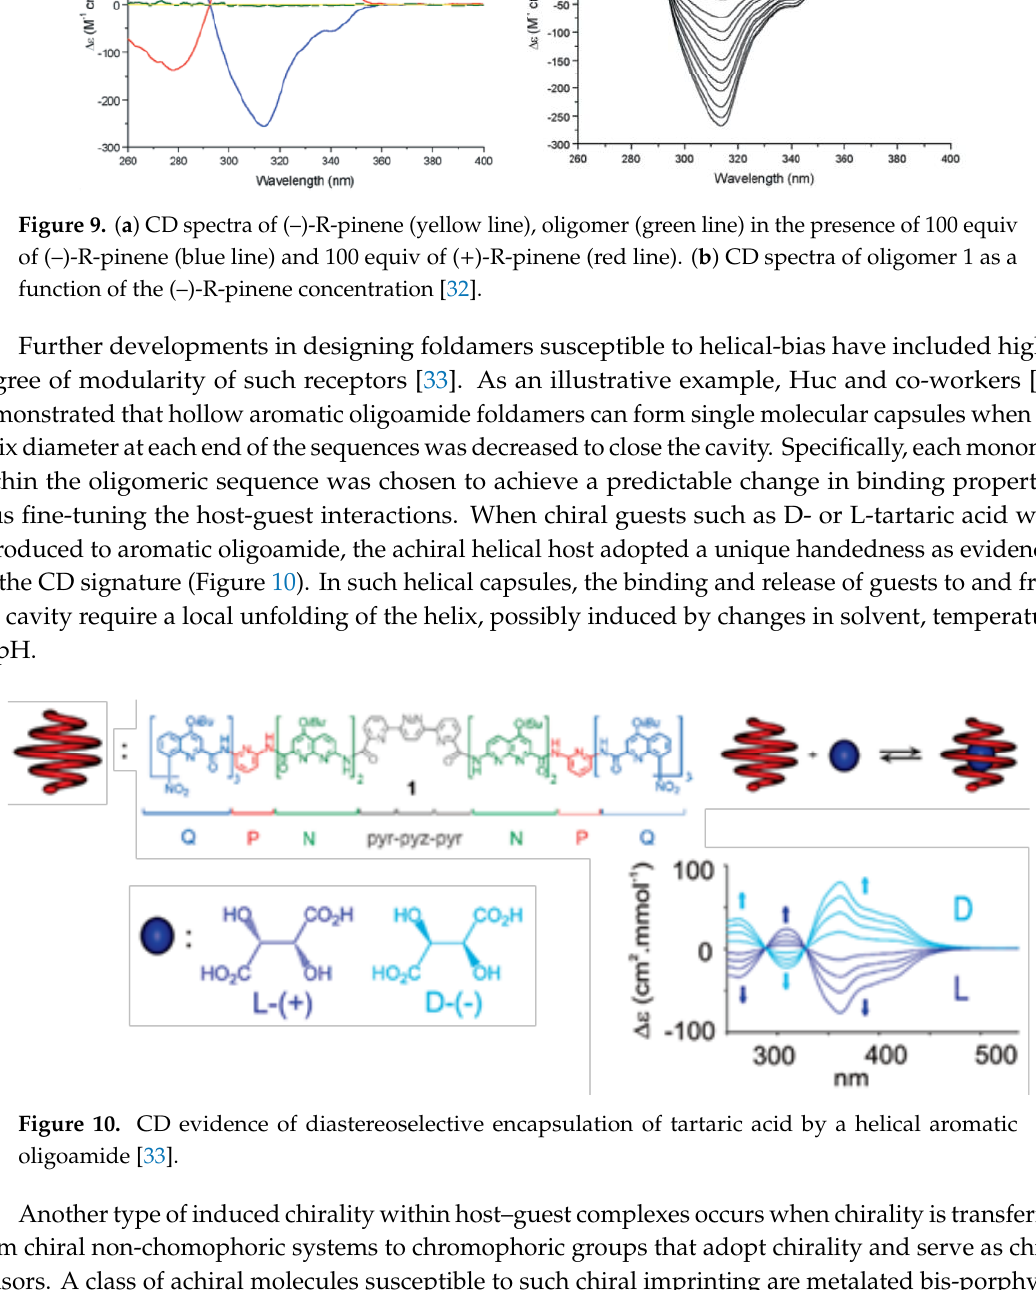
Figure 8. Association models of oligomeric phenylene ethynylene foldamer encapsulating (-)-R- pinene [32].